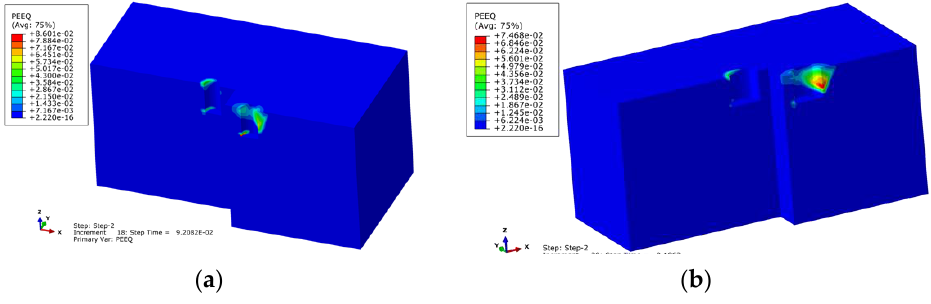
Figure 16. Soil equivalent plastic strain contours at 1# and 2# bucket central section for the TSPJF and TBJF under the ultimate horizontal load. ( a ) TSPJF, ( b ) TBJF. The horizontal and vertical resistance of each part of the buckets of the TSPJF and TBJF under ultimate horizontal load are shown in Figures 17 and 18, respectively. It can